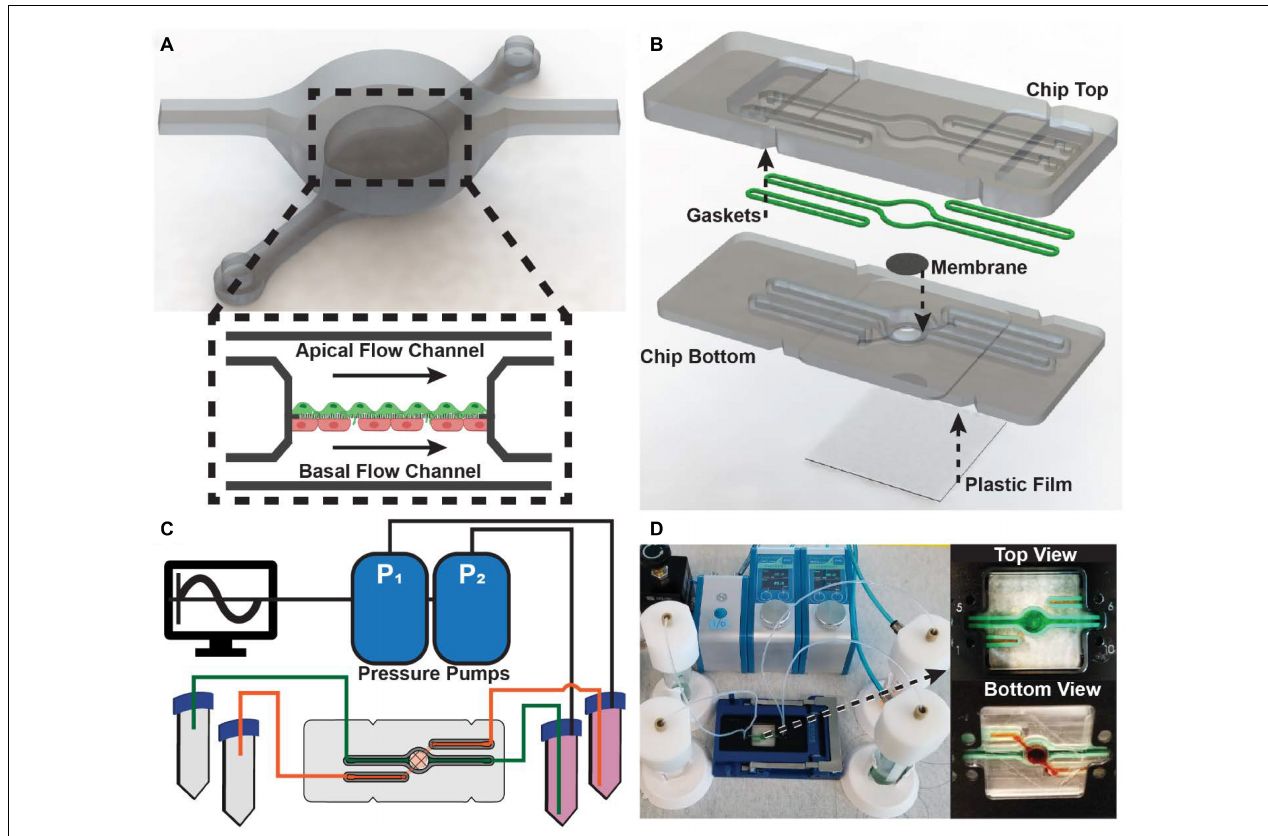
FIGURE 1 | Design and assembly of the modular MPS: (A) 3D render of fluidic channel geometry implemented in microfluidic chip (Inset) Schematic representation of internal culture well with independent apical and basal channels and a co-culture of endothelial and epithelial cells supported by a porous membrane. (B) Exploded view of the microfluidic chip comprised of a top and bottom piece, gaskets, porous support membrane, and an oxygen-permeable plastic film. The arrows indicate how the components are bonded into the chip. (C) Schematic representation of the MPS comprised of two pressure pumps controlled by a computer, media reservoirs, and the microfluidic chip. (D) Fully assembled and running MPS. (Insets) Top and bottom view showing leak-free perfusion of dyed water through the microfluidic